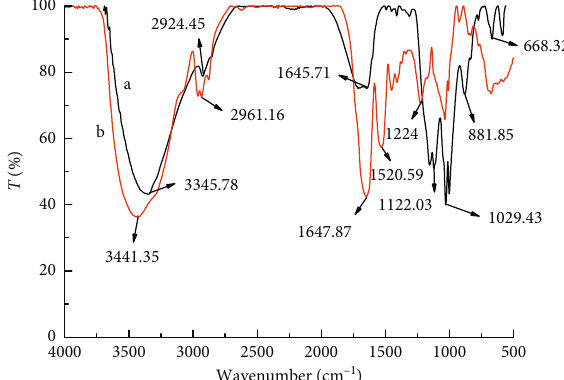
Figure 14: Infrared spectrum of SPS nanospheres (a) and immobilized enzymes